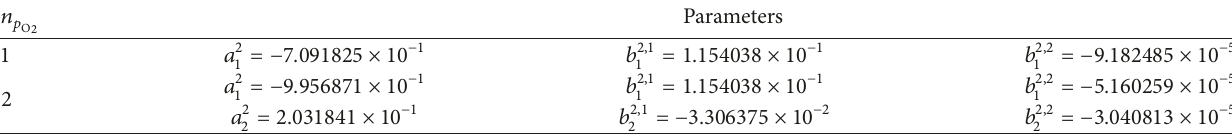
calculated by the first algorithm. O 2